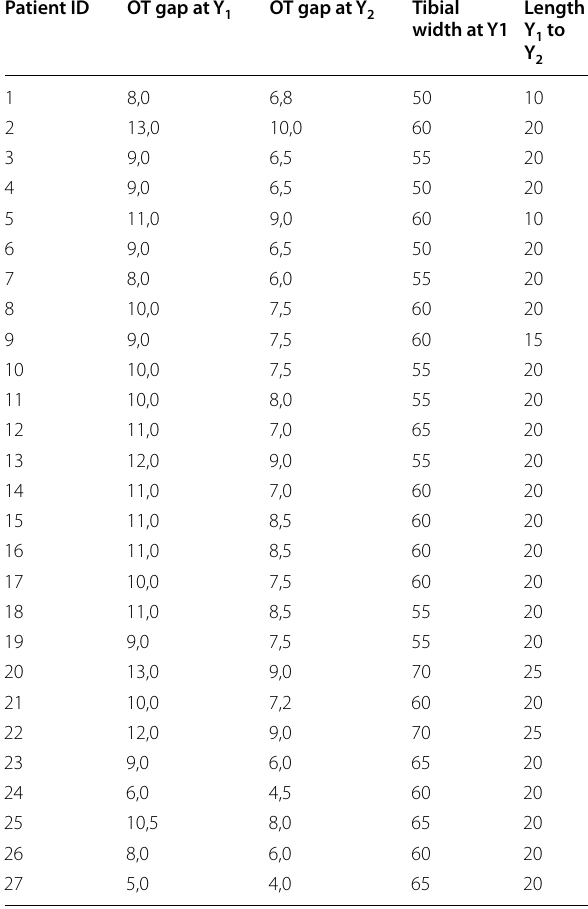
Table 2 Osteotomy gap width at the anteromedial and posteromedial osteotomy